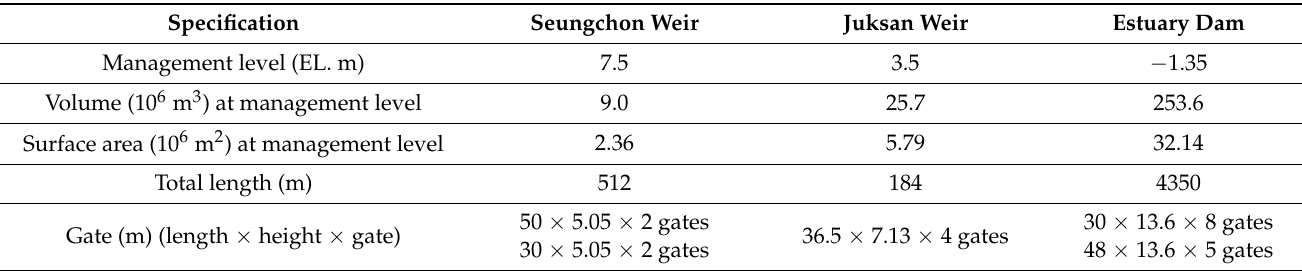
Table 1. Specifications of the Seungchon and Juksan Weirs and the estuary dam. Specification Seungchon